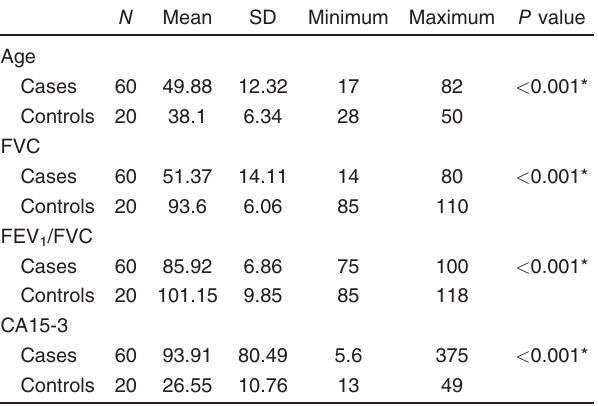
Table 1 Demographic data and pulmonary function parameters of patients with interstitial lung diseases and controls